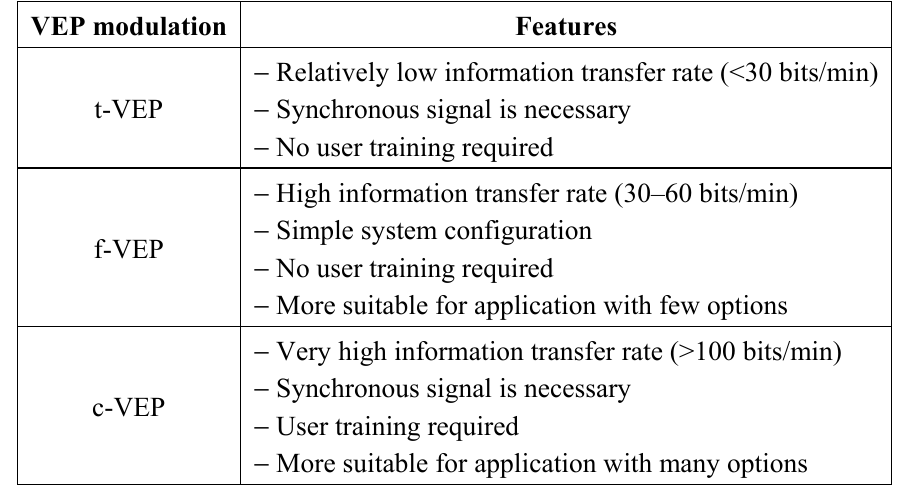
Table 3. Features of VEP modulations: t-VEP, f-VEP and,